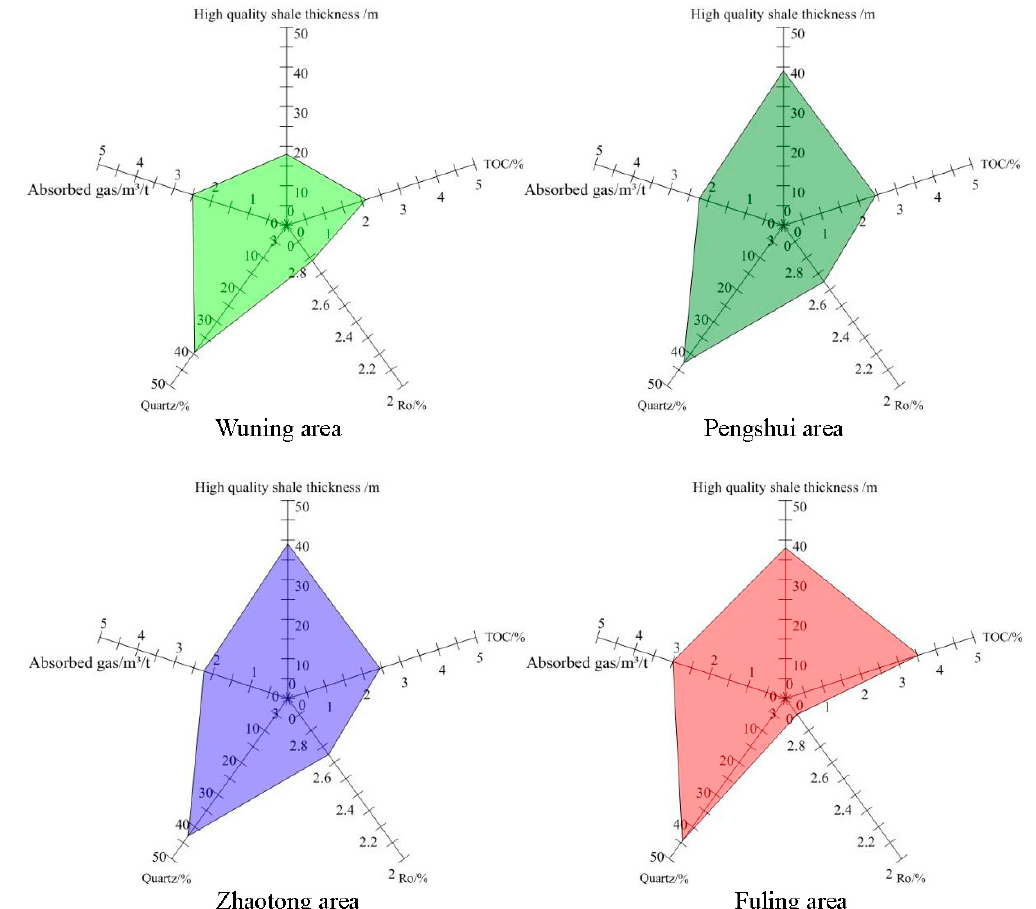
Figure 14. Comparison of the key shale-gas parameters between the Xinkailing-formation shale in Wuning and the Longmaxi shale in the middle-upper Yangtze area.